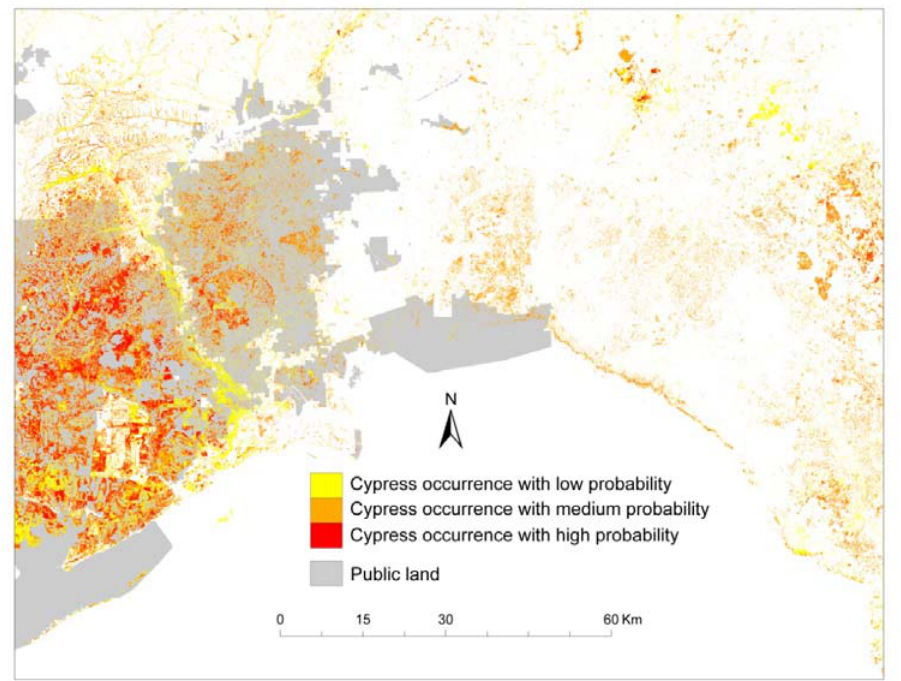
Figure 4. Examples of cypress occurrence with three probabilities on public